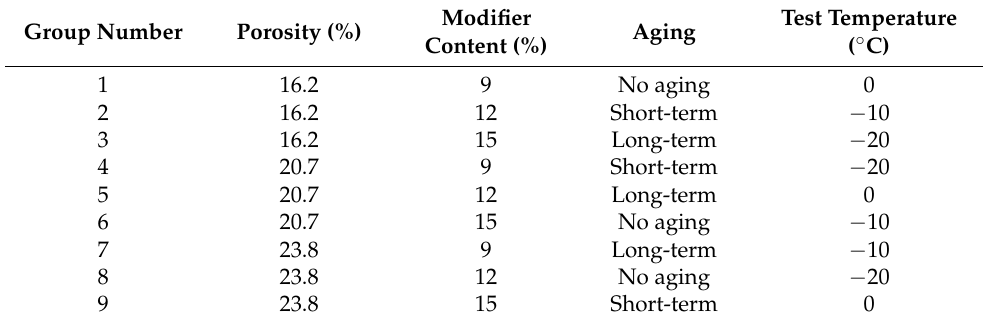
Table 13. Orthogonal test